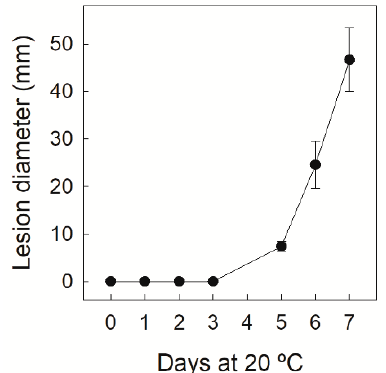
Figure 1. Lesion diameter (mm) of the macerated area of the Navelate orange infected at a depth of 4 mm with 10 4 conidia mL − 1 of P. digitatum (10 µL). The error interval indicates the standard deviations of the estimated mean value.